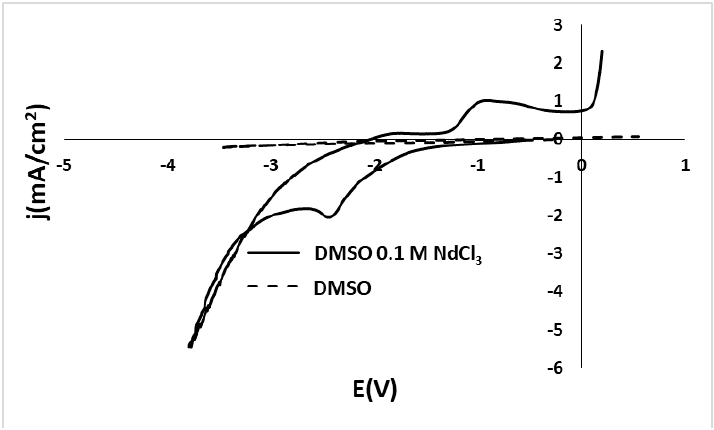
Figure 4. Cyclic voltammogramm of DMSO_0.1 M NdCl 3 (solid line) and DMSO (dash line).